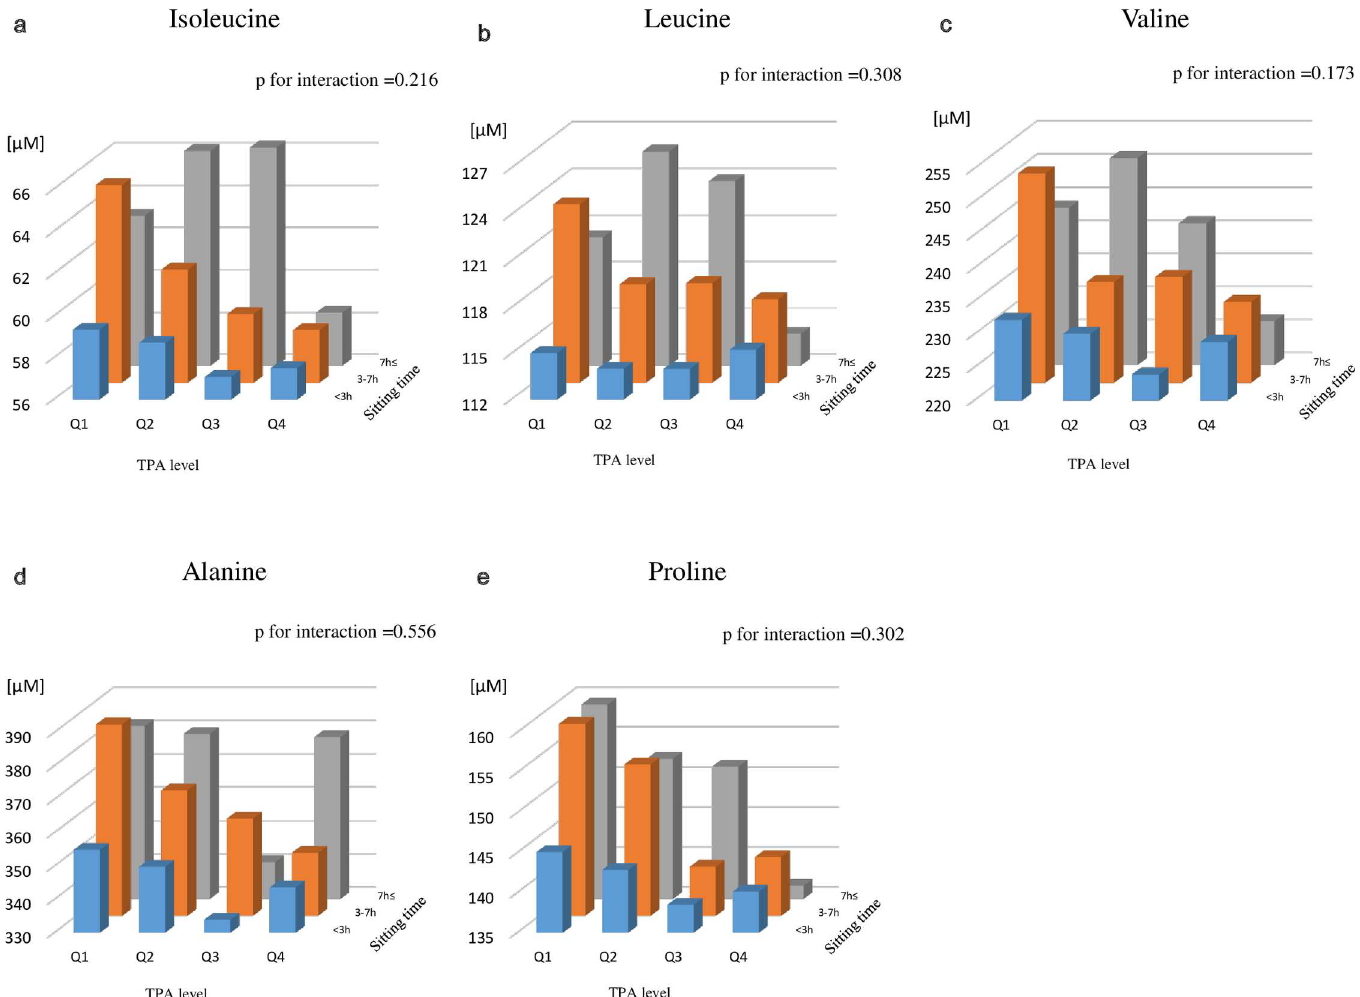
Fig 4. Cross-classified multivariable-adjusted mean concentrations of metabolites associated with TPA and sedentarybehavior levels. Multivariable-adjusted(age, BMI, smoking, alcohol, energy intake) mean concentrations were calculated by groups cross-classified by TPA level and sitting time. Metabolites that showed a strong associationwith both exposures (Figs 2 and 3) are shown. P-values for interactions between TPA and sitting time levels were tested. Details of the number of subjects in each cross-classified group are shown in S2